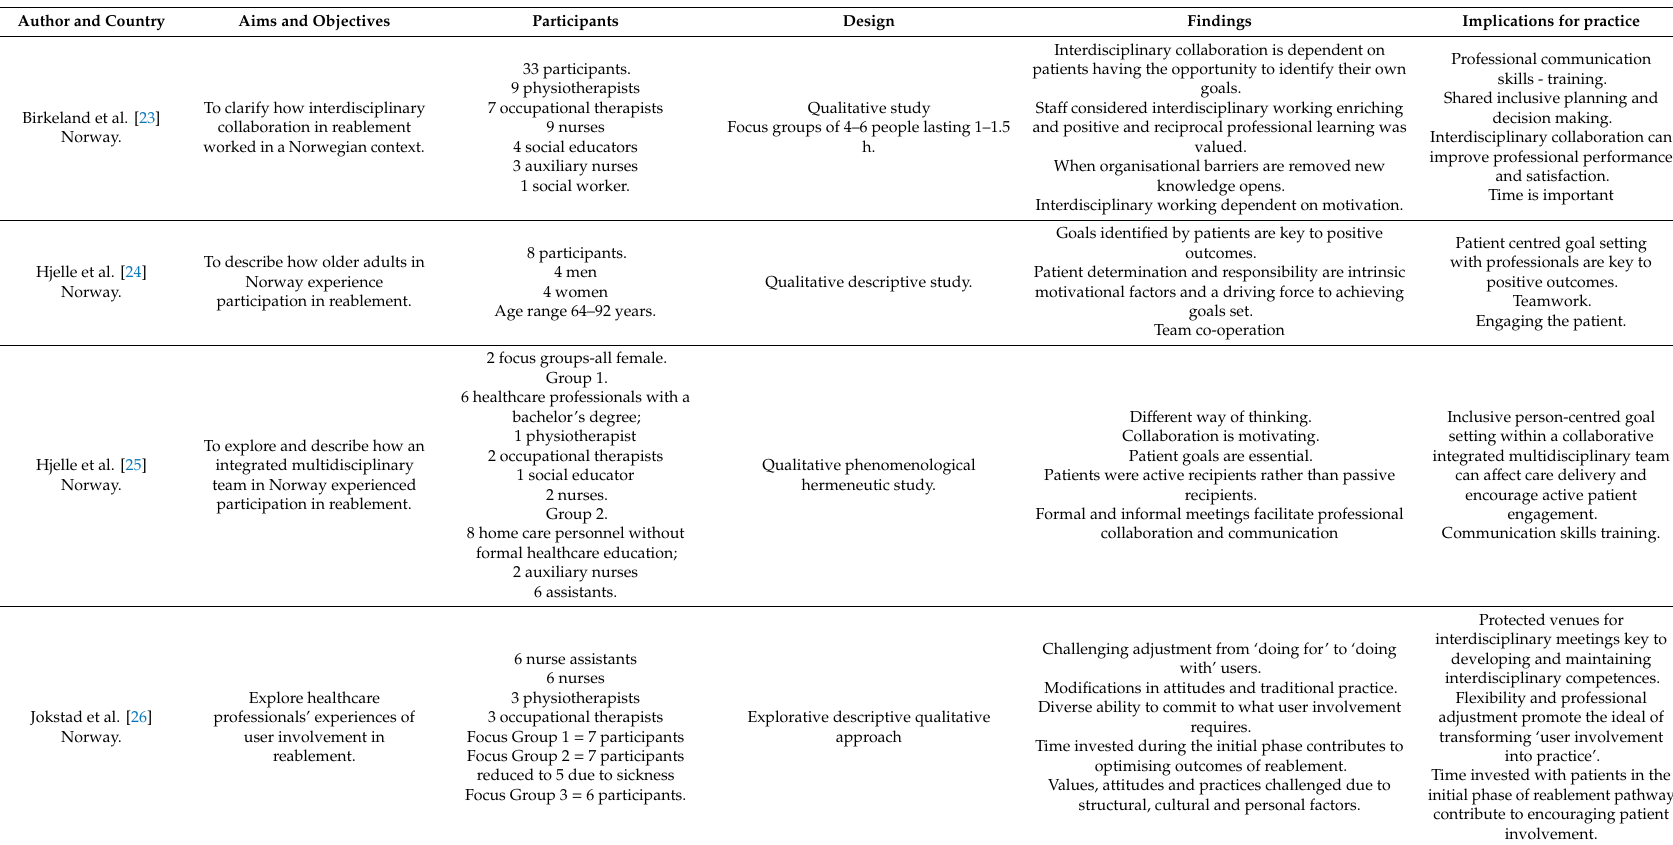
Table 2. Summary of the findings and implications for practice of the studies